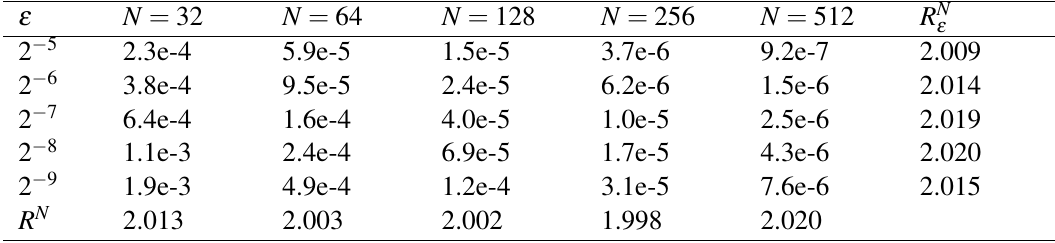
Table 1 Maximum errors and rates of convergence w